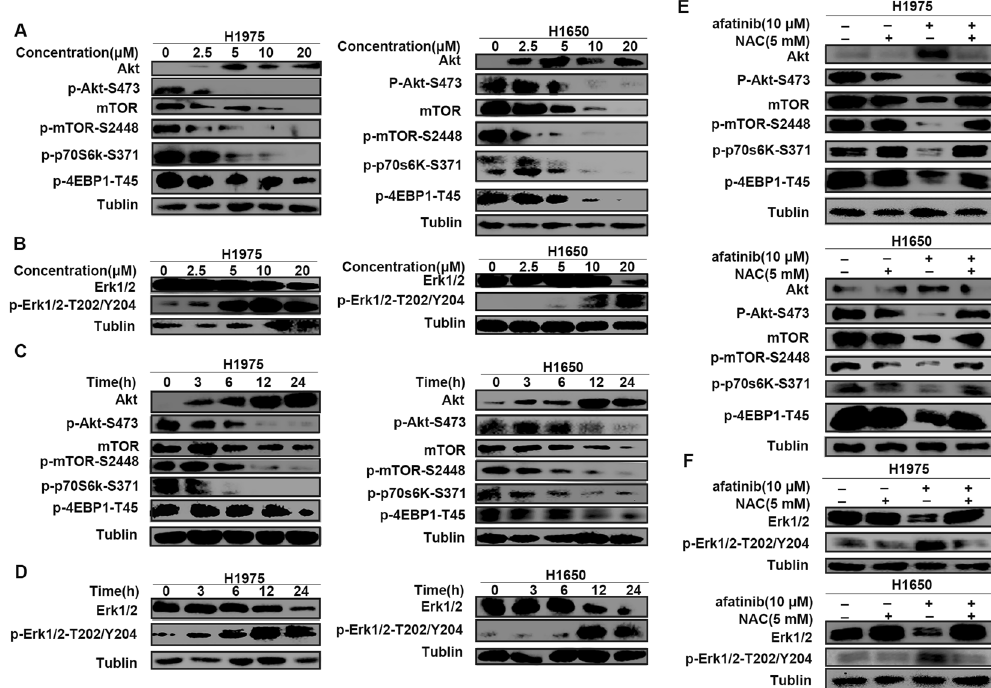
Figure 6. The afatinib-induced autophagy is related to the Akt/mTOR and Erk signaling pathways. ( A and B ) H1975 and H1650 cells were stimulated by various concentrations of afatinib for 24 h. ( A ) The levels of Akt, p-Akt, mTOR, p-mTOR, p-P70S6K and p-4EBP1 were analyzed by western blot. ( B ) The levels of Erk 1/2 and p-Erk1/2 were analyzed by western blot. ( C and D ) H1975 and H1650 cells were treated with 10 μ M afatinib for 0, 3, 6, 12 and 24 h. ( C ) The levels of Akt, p-Akt, mTOR, p-mTOR, p-P70S6K and p-4EBP1 were analyzed by western blot. ( D ) The levels of Erk 1/2 and p-Erk1/2 were detected by western blot. ( E and F ) H1975 and H1650 cells were treated with 10 μ M afatinib in combination with or without 5 mM of NAC for 24 h. ( E ) The levels of Akt, p-Akt, mTOR, p-mTOR and p-P70S6K were analyzed by western blot. ( F ) The levels of Erk1/2 and p-Erk1/2 were analyzed by western blot. ( A – F ) All blots were cropped with Photoshop